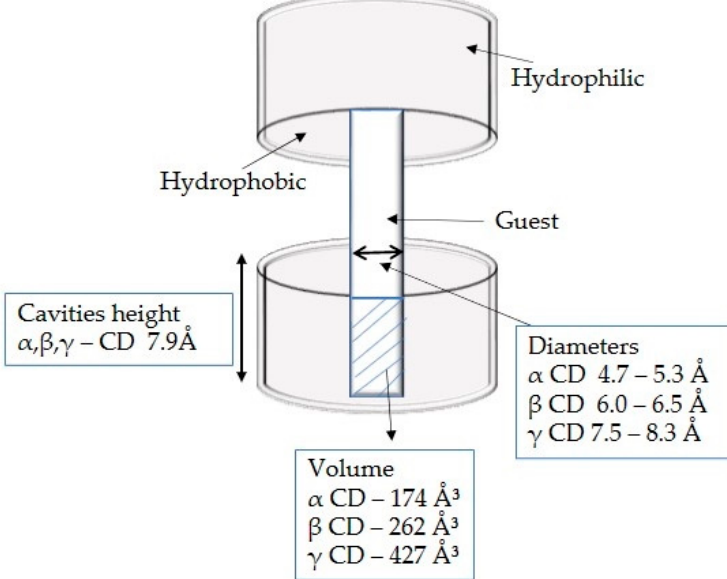
Figure 4. The heights, internal diameters, and cavity volumes of α , β , and γ CDs.